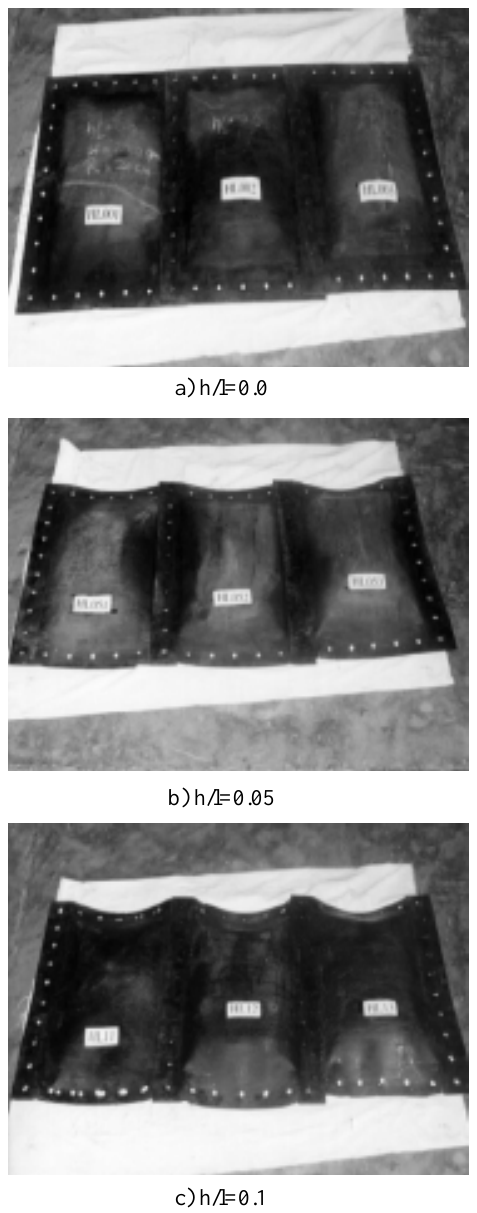
Fig. 5. Dishing of shell panels (3 in each category, see Table 1) (Panels shown concave